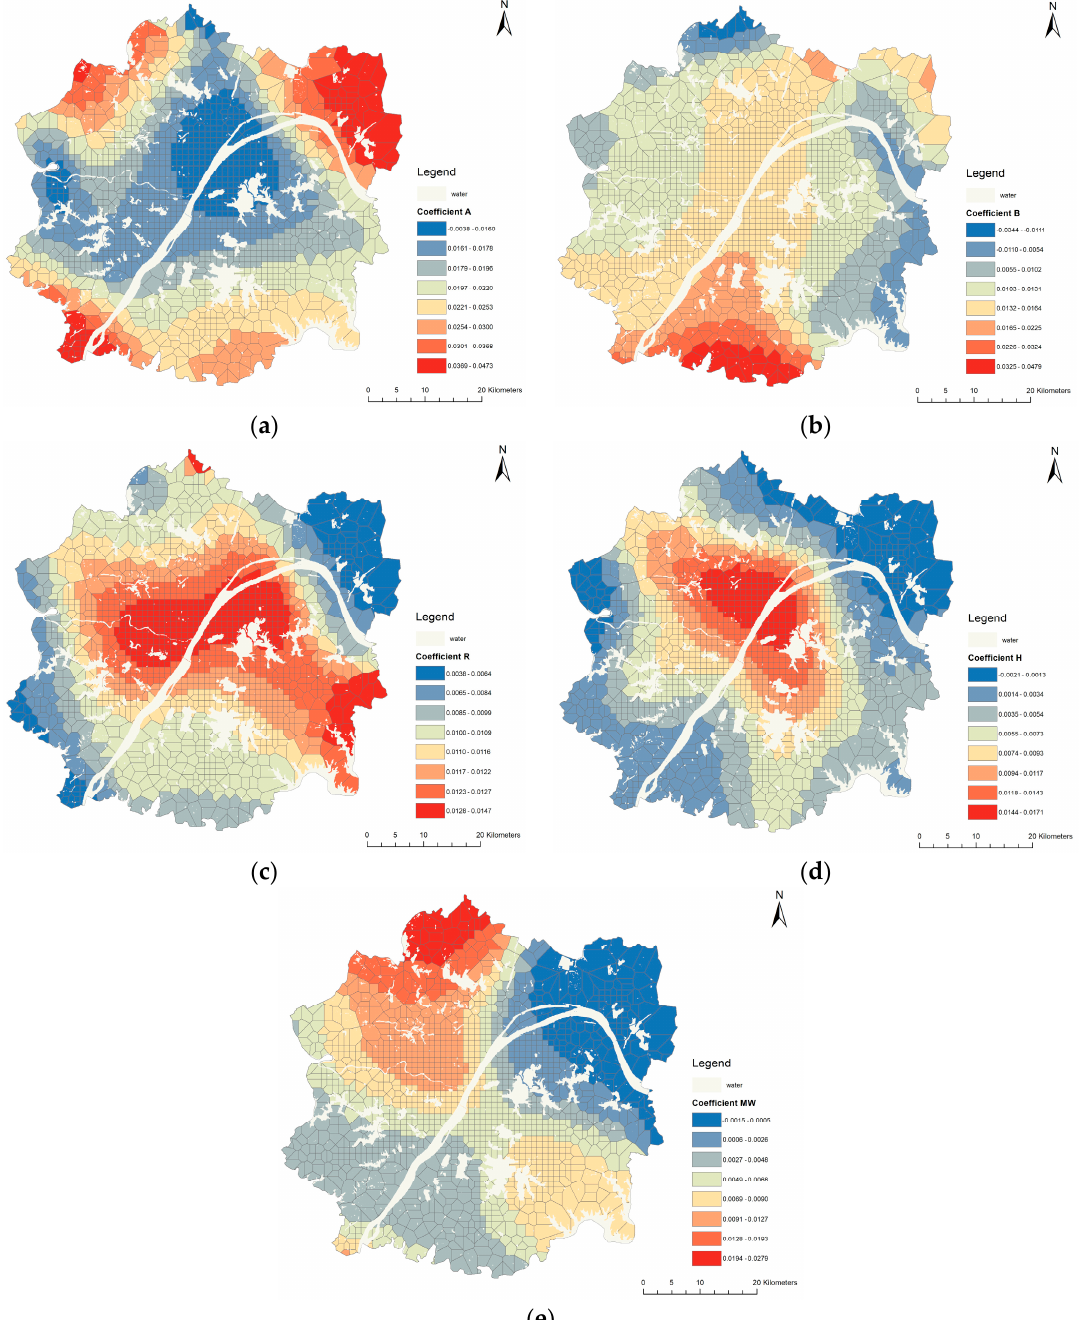
Figure 9. Spatial statistics of variable coe ffi cients: ( a ) Coe ffi cient A (administrative and public service building); ( b ) Coe ffi cient B (commercial service facility building); ( c ) Coe ffi cient R (residential building); ( d ) Coe ffi cient H (development and construction building); ( e ) Coe ffi cient MW (industrial and logistics storage